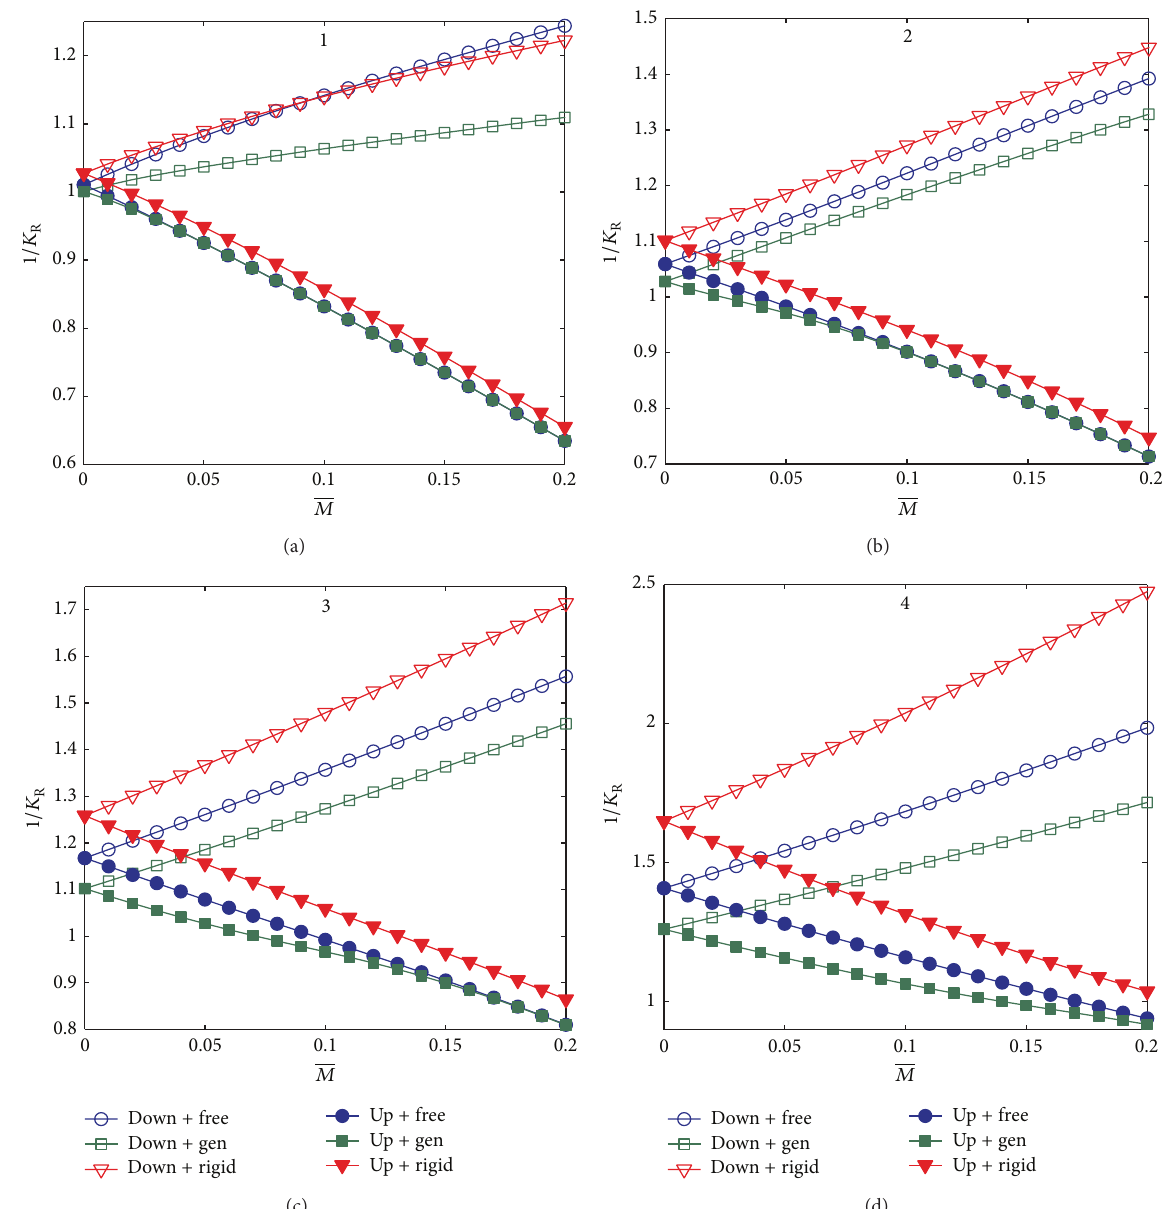
Figure 2: (Color online) Comparison of the relative phase velocity of the first four axisymmetric pseudo-modes with three different types of boundary condition in the laminar